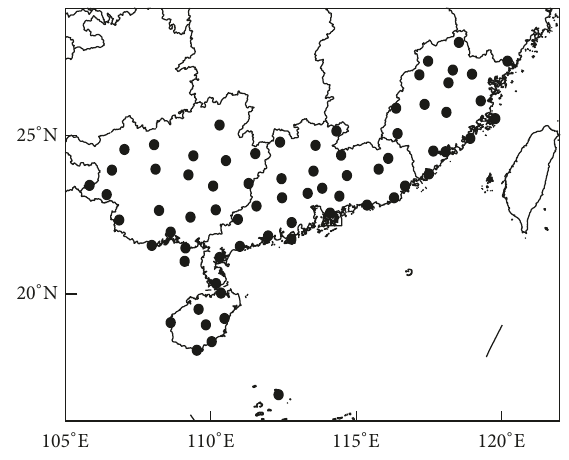
Figure 1: The 71 rainfall stations in South